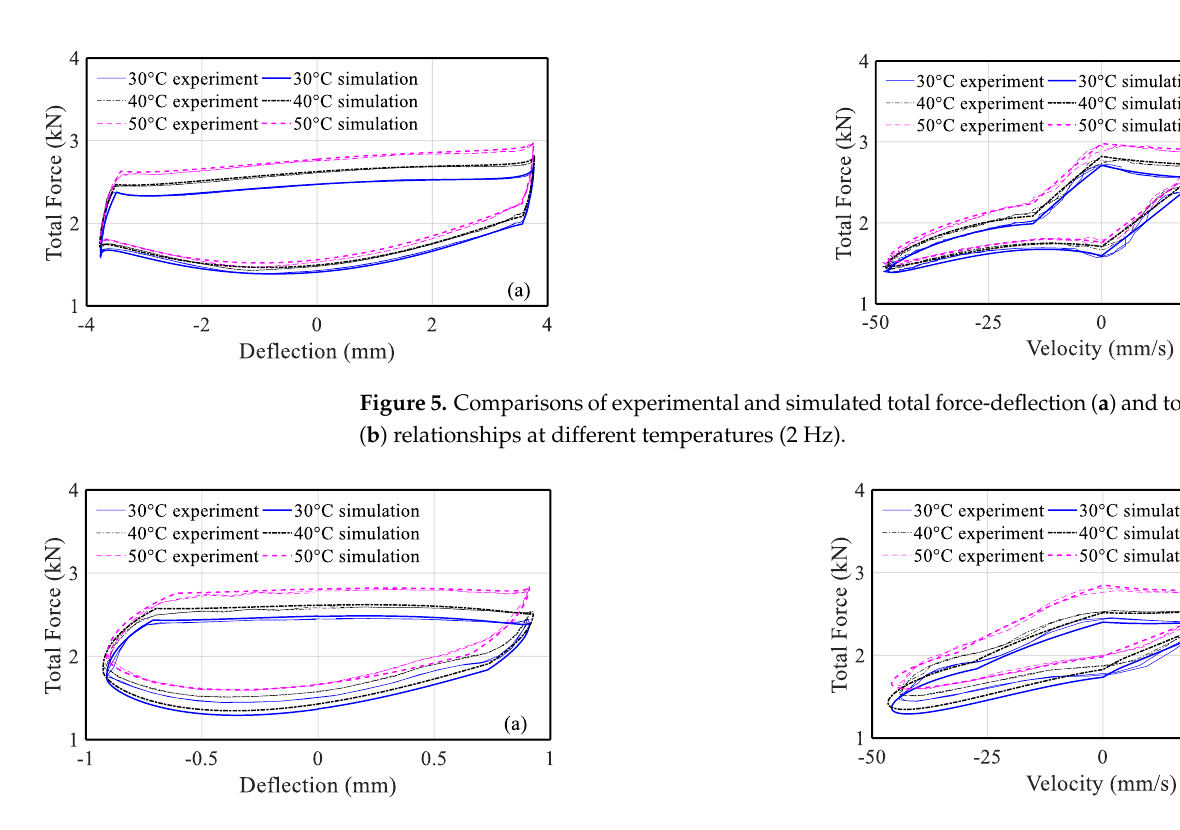
Figure 4. Comparisons of experimental and simulated total force-deflection ( a ) and total force- velocity ( b ) relationships at different temperatures (0.5 Hz).